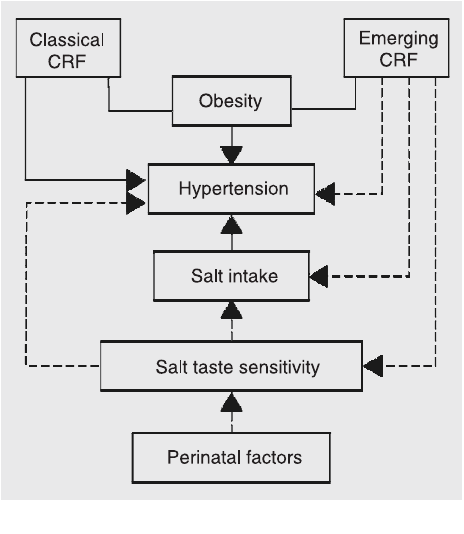
Figure 2. Forced-choice stair- case method for the detection of threshold for salt taste sensi-